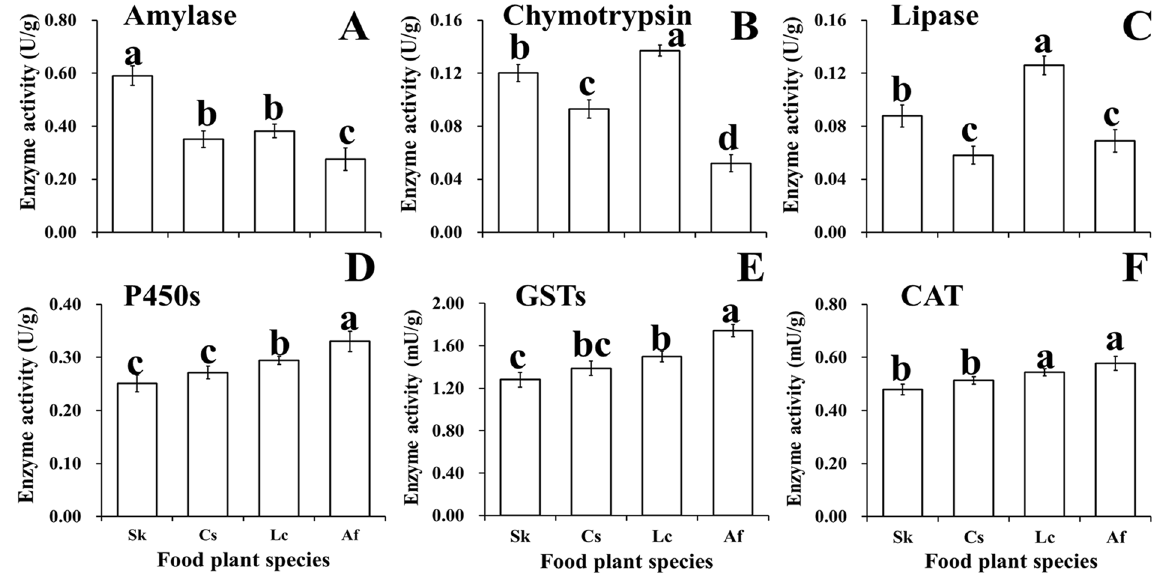
Figure 4. The activity ( ± SD) of the main digestive (amylase, chymotrypsin, lipase) and detoxification (P450s: cytochrome P450s, GSTs: glutathione-S-transferase, CAT: carboxylesterase) enzymes for O. asiaticus when fed on L. chinensis (Lc), S. krylovii (Sk), C. squarrosa (Cs), and A. frigida (Af). Bars marked by different lowercase letters are significantly different based on Turkey’s HSD analysis at P < 0.05.